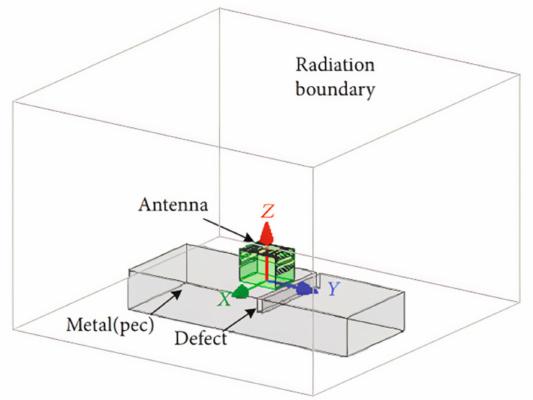
Figure 8. Simulation process of 3D RFID tag antenna on the metal structures with defects